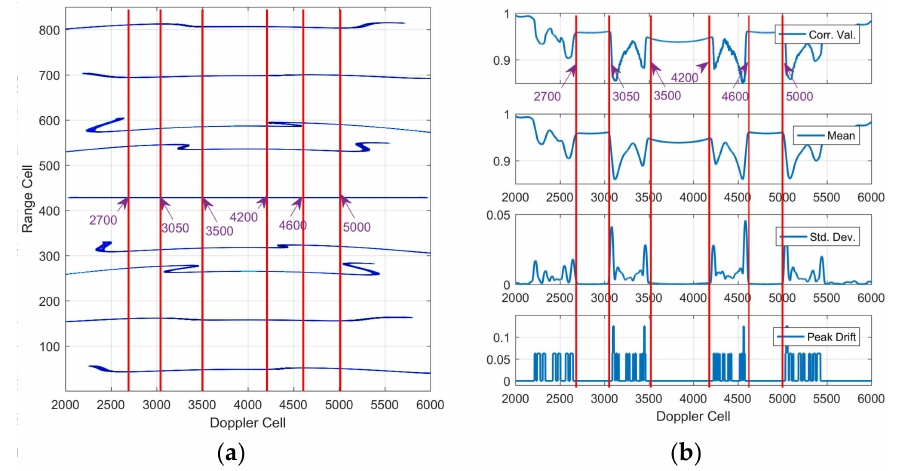
Figure 3. Correlation characteristics of simulated data. ( a ) Data in the range-Doppler domain; and ( b ) the four correlation